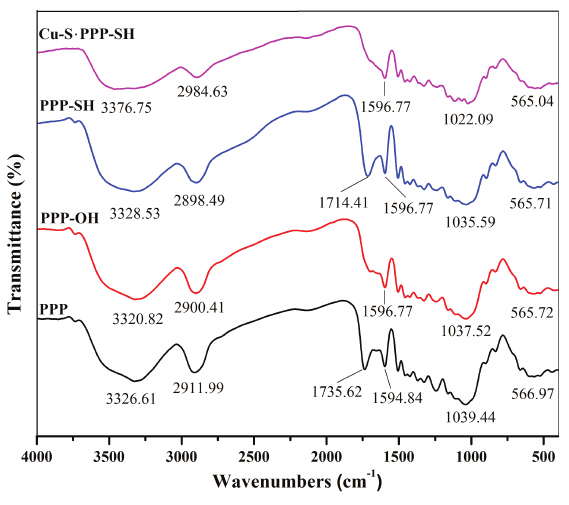
Figure 1: FTIR spectra of PPP, PPP-OH, PPP-SH and